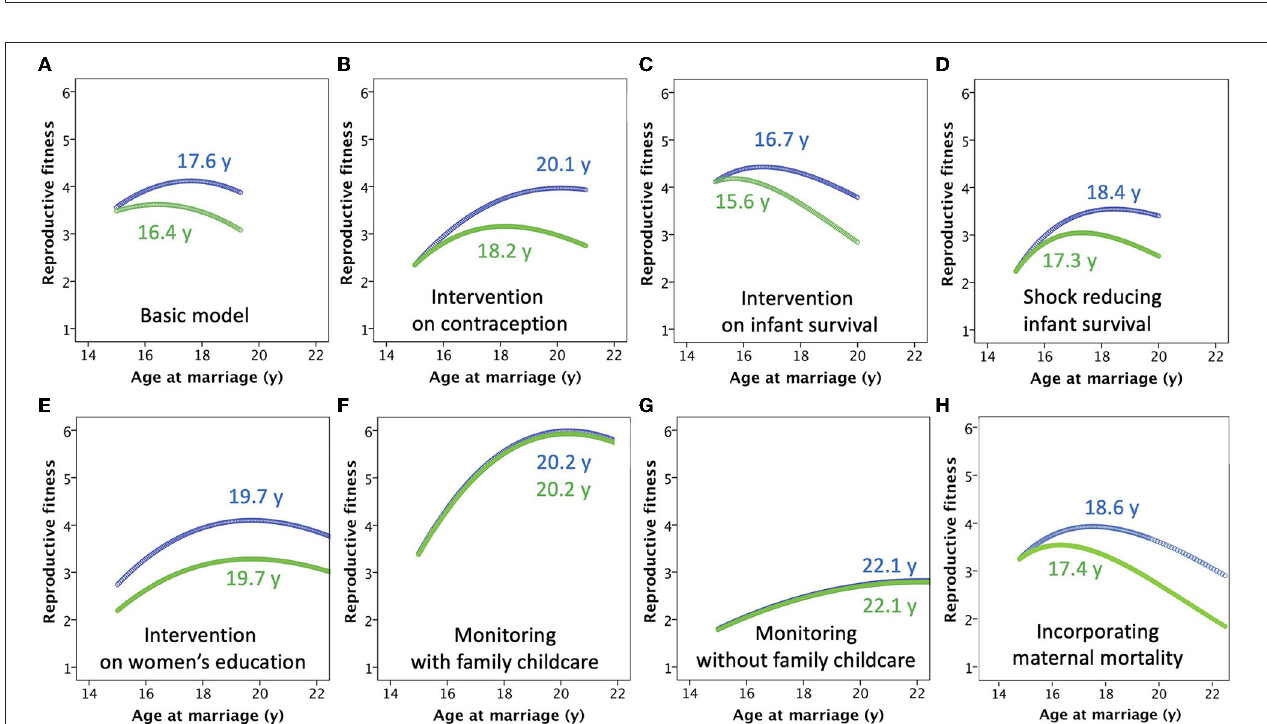
FIGURE 4 | Basic associations of age at women’s marriage with (A) their lifetime fertility and (B) the rate of child mortality, calculated as the fraction surviving by combining the associations illustrated in Figure 2 .